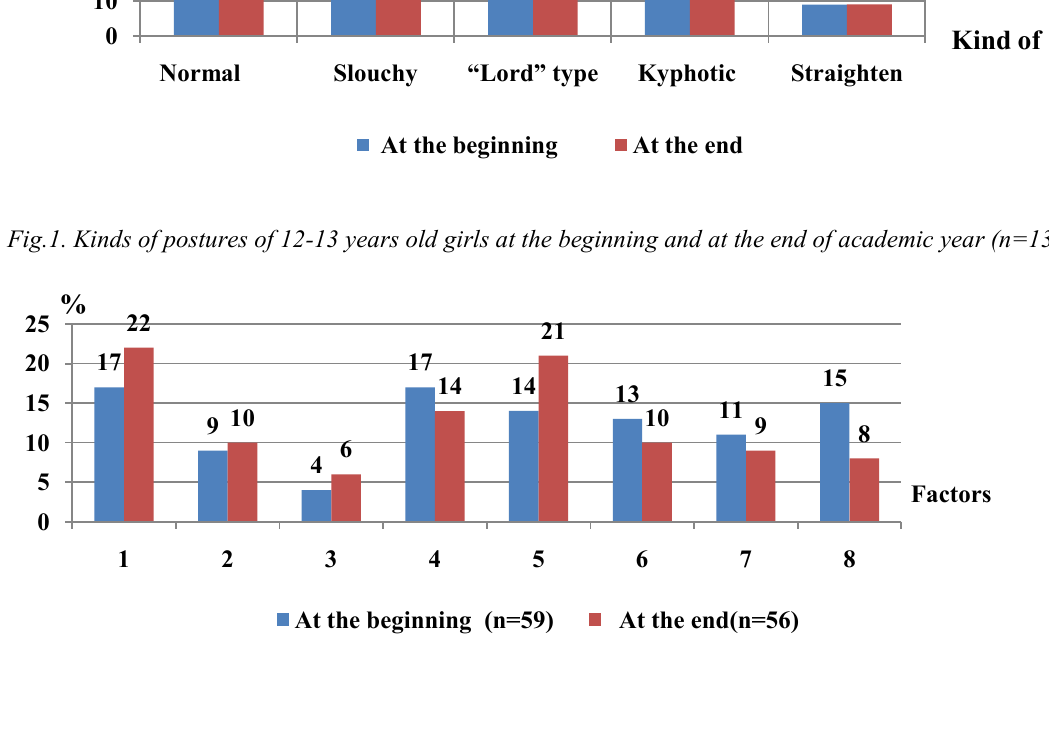
Fig.2. Factors of school anxiety of girls with normal posture during academic year: 1 – general anxiety at school; 2 – feeling of social stress; 3 – frustration of demand in success; 4 – far of self-expression; 5 – fear of situation of testing knowledge; 6 – fear of not compliance with expectations of surrounding people; 7 – low physiological resistance to stress; 8 – problems and fears in relations with